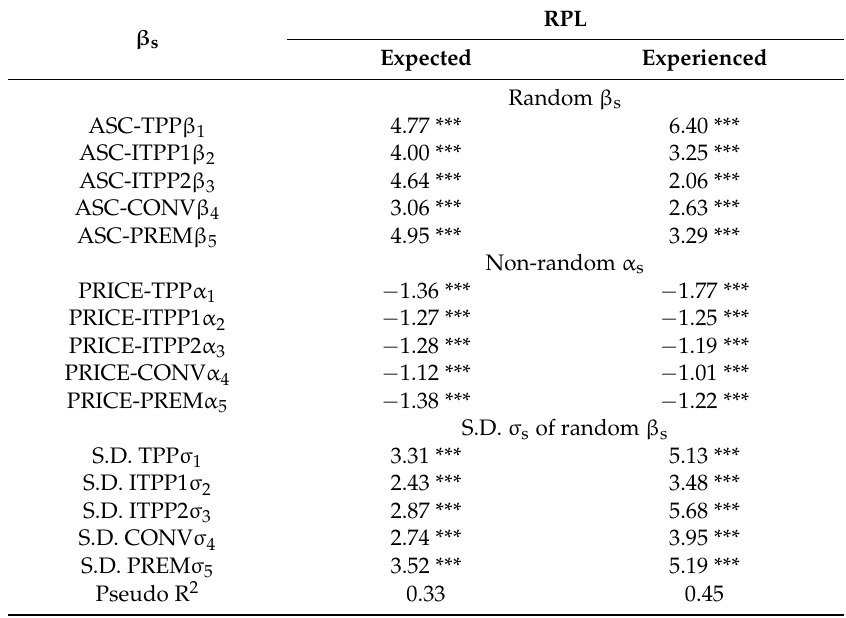
Table 3. Random parameters logit (RPL) models before and after the hedonic evaluation test. β